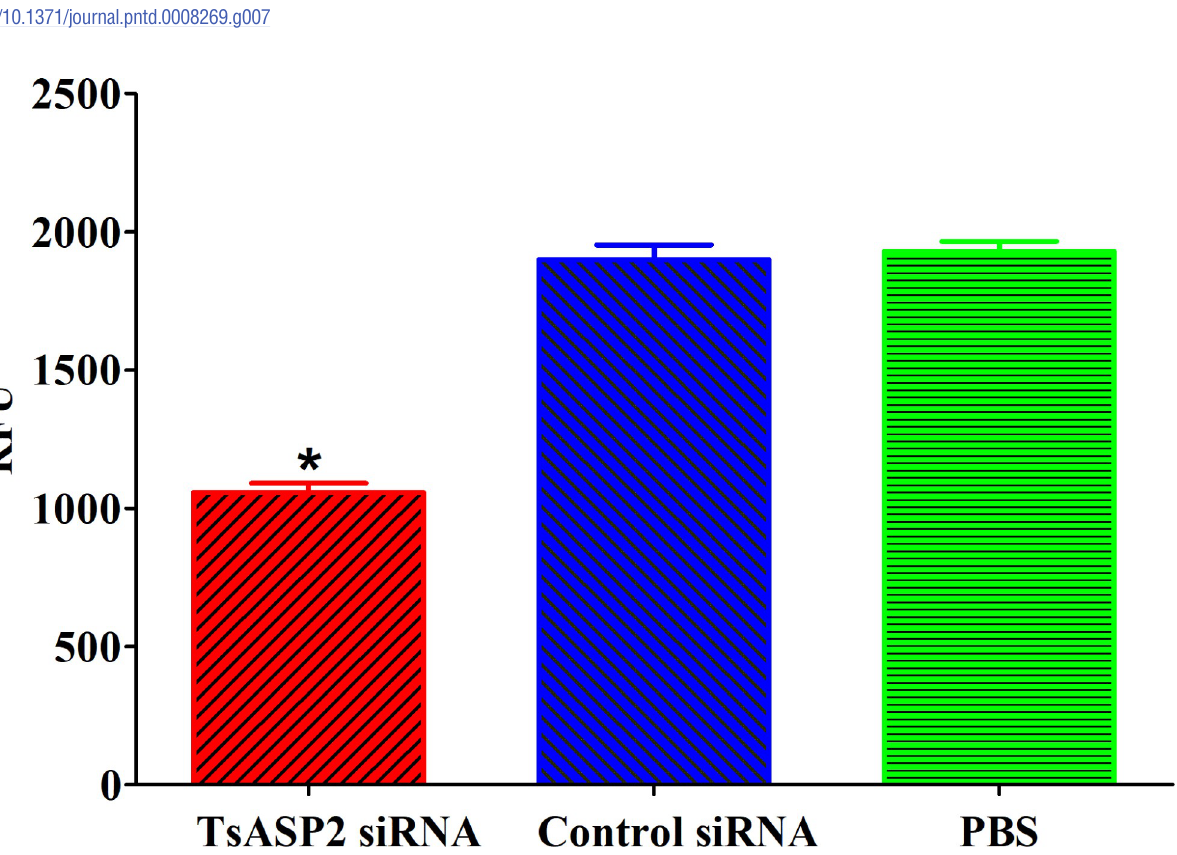
Fig 8. Effects of TsASP2 RNAi on aspartic protease enzymatic activities of ML. Aspartic protease activity in crude proteins of T . spiralis ML treated with siRNA was detected with a fluorogenic substrate. Asterisks indicate a statistically significant difference compared with the control siRNA and PBS groups ( � P <